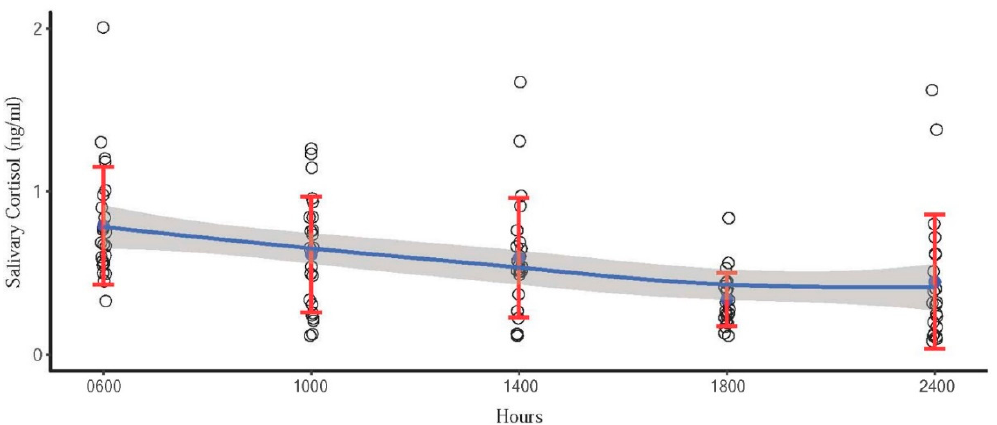
Figure 2. Scatter plot indicating linear circadian pattern of cortisol concentrations in 10 Asian elephants. Blue dots represent the mean concentration of each time point. Red error bars represent the standard deviation. Blue line represents the trend line, and the shaded area is a 95% confidence interval of the mean.